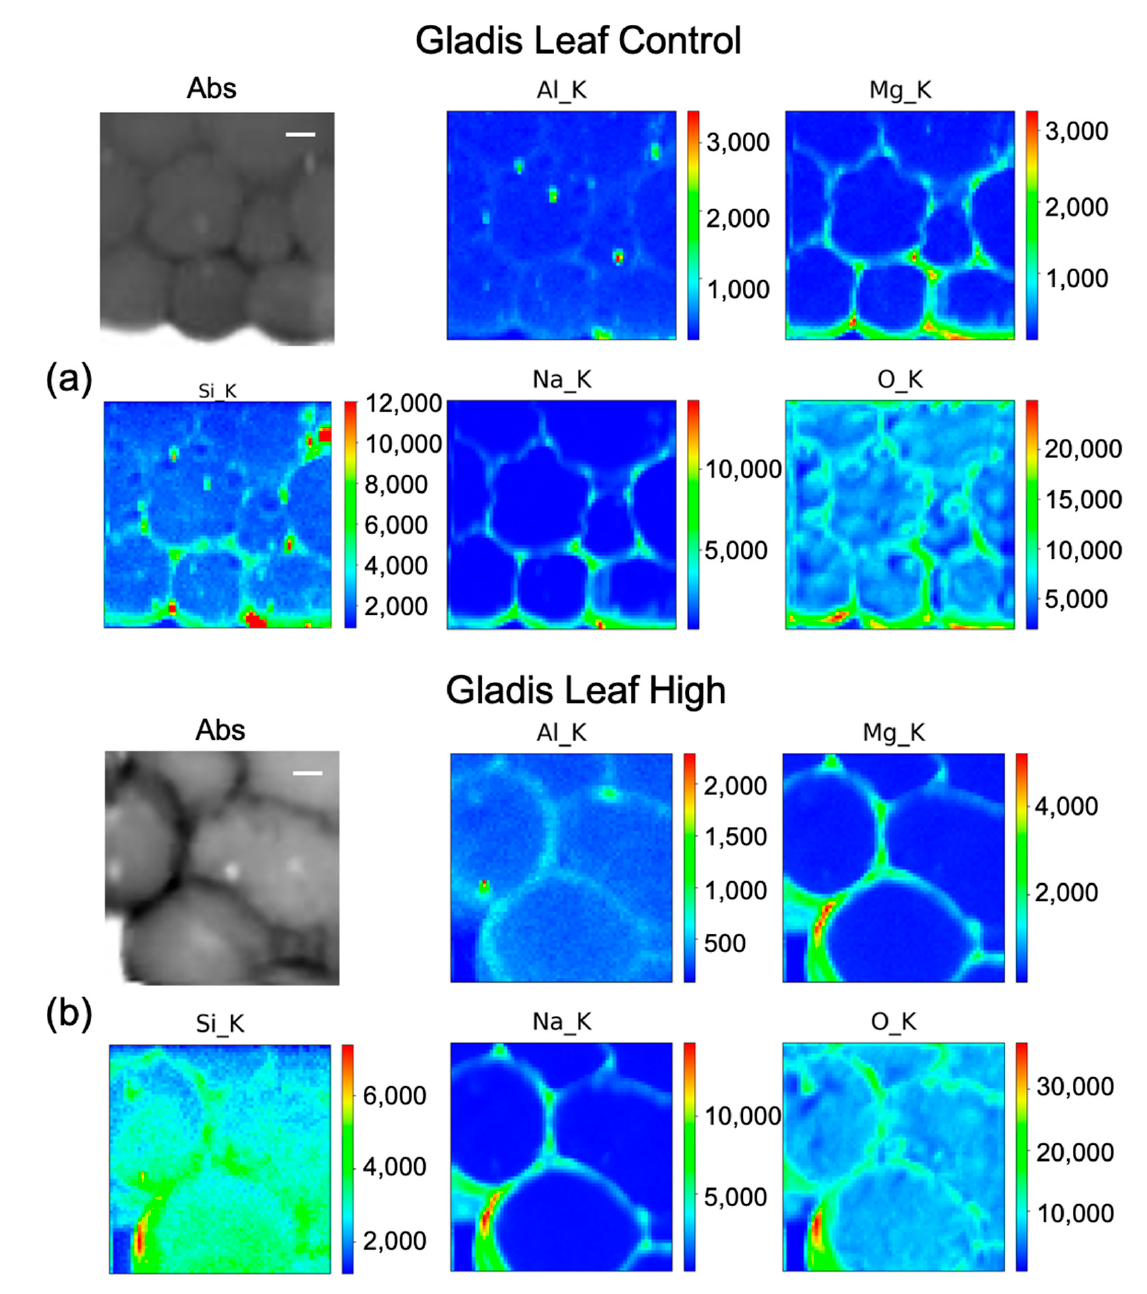
Figure 9. Micro-X-ray Fluorescence ( µ -XRF) elemental maps of O, Al, Na, Mg, and Si, depicting the distribution within the cells of ( a ) Gladis Leaf Control, and of ( b ) Gladis Leaf High Si treatment, shown with their corresponding absorption image (Abs). Scale bar is 10 µm.